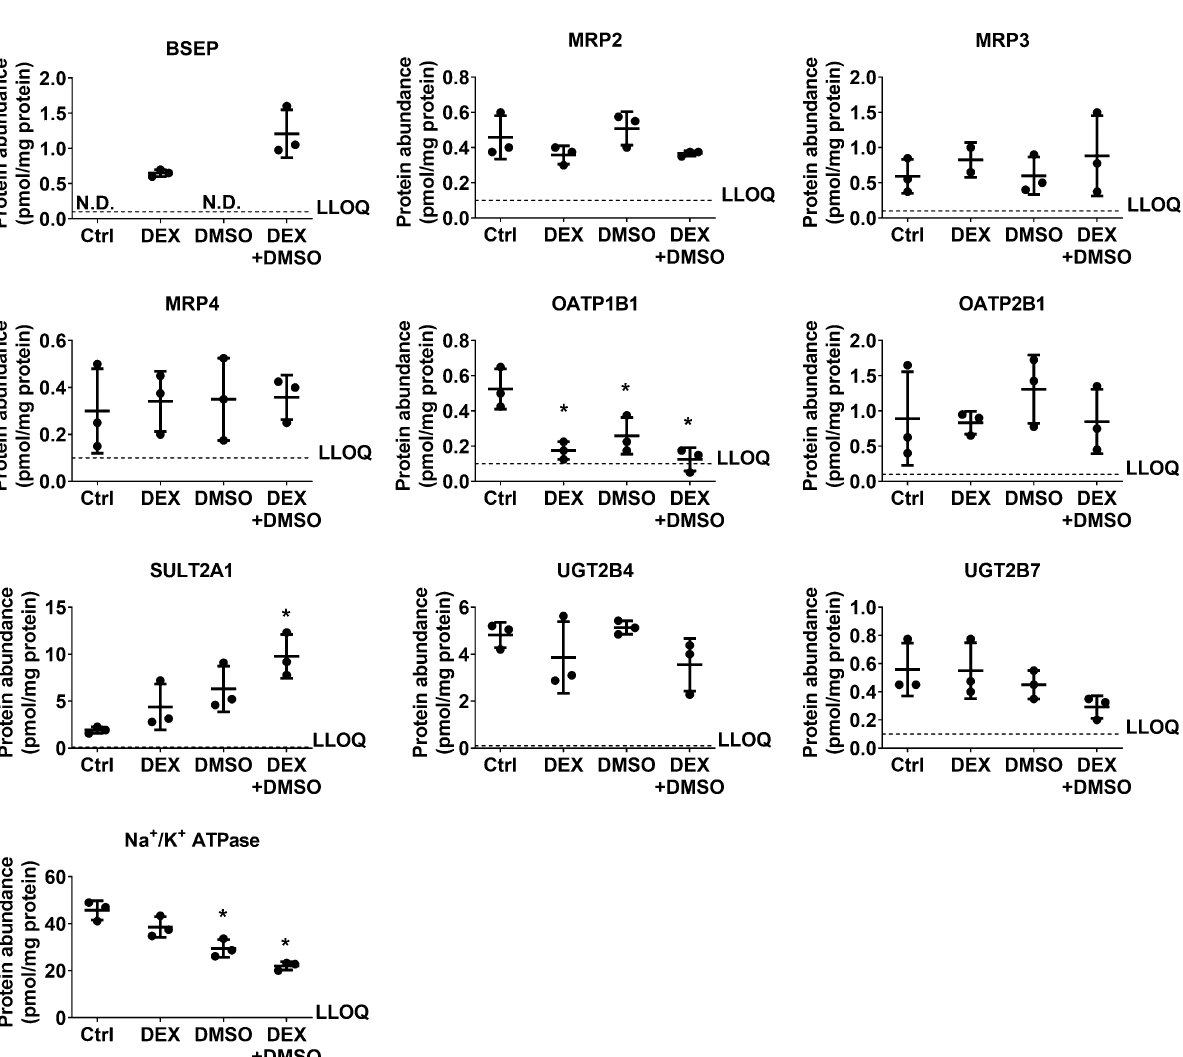
Figure 3. Abundance of bile acid-relevant proteins in differentiated HuH-7 cells with overlay measured by quantitative targeted absolute proteomics (QTAP) analysis. Membrane protein abundance (pmol/mg protein; mean ± standard deviation, n = 3) of select bile acid-relevant proteins in 2-week cultured HuH-7 cells treated with 1 µM dexamethasone (DEX) and/or 0.5% DMSO was plotted as scatter plots for individual proteins. Statistically significant differences with respect to control (Ctrl) were calculated for each protein using an ordinary one-way ANOVA and Dunnett’s multiple comparison test (*, p < 0.05). N.D., not detected; LLOQ, lower limit of quantitation (0.1 pmol/mg